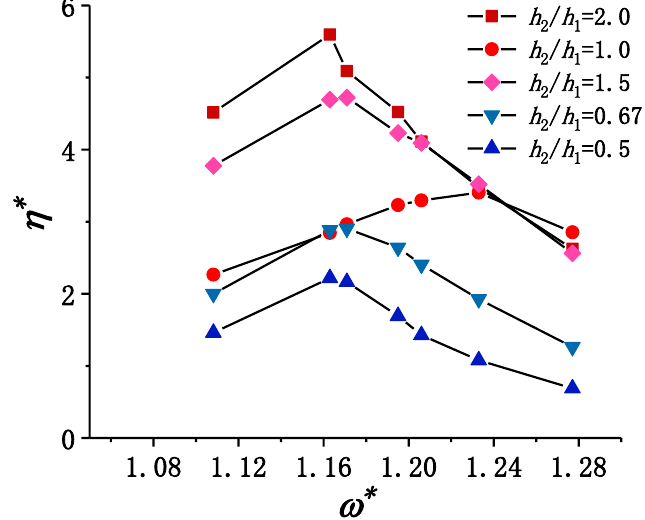
Figure 8. Fluid oscillation amplitude profiles against angular frequency of incident wave for different draft ratios.